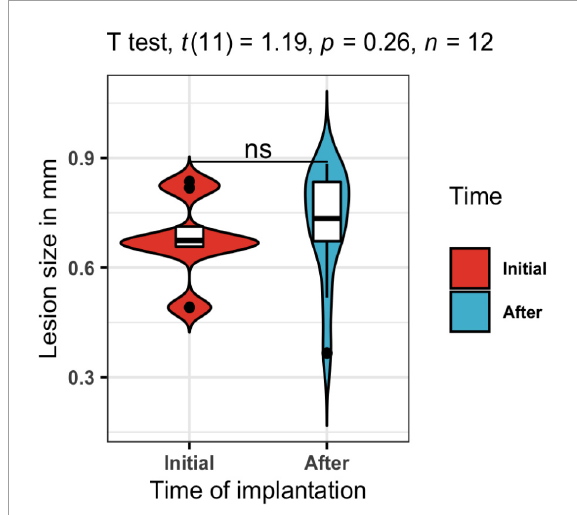
FIGURE7 Lesion size in mm. A t -test was calculated to compare the lesion size at 2 points right after the surgical implantation P100 in blue (Initial) and at the end of the stimulation protocol P145 in red (After). The average lesion size of the twelve rats was not significantly increased after the treatment (stimulation) application, t (11) = 1.19, p = 0.26, d =